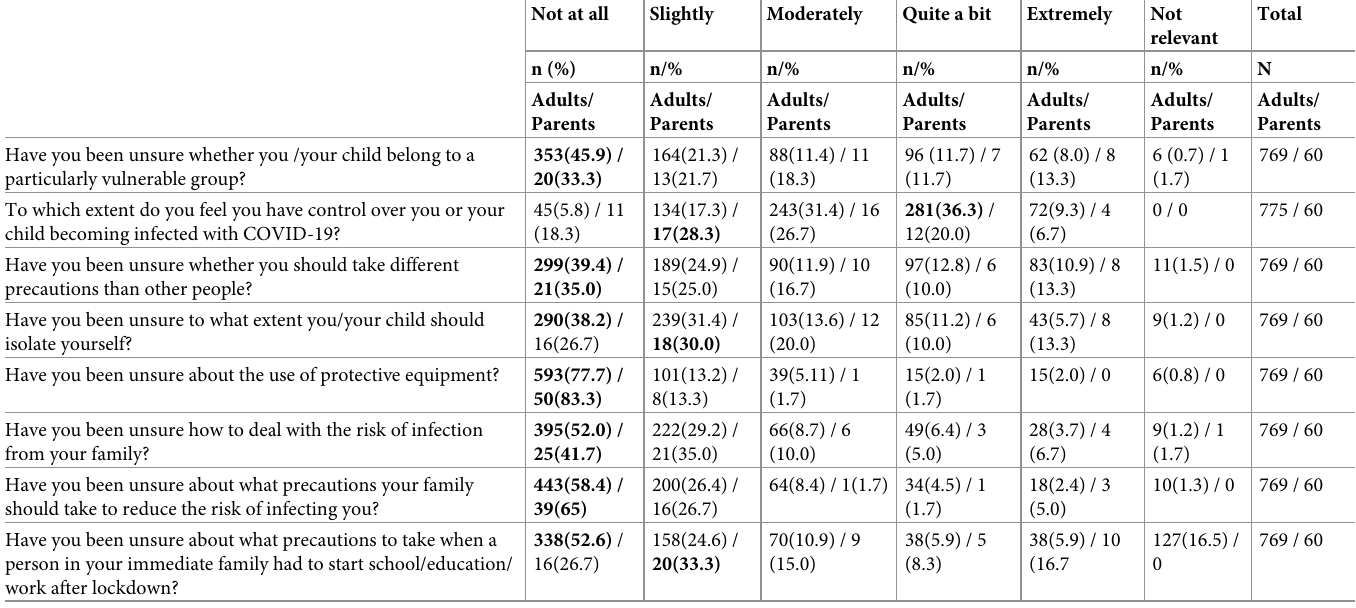
Table 4. Perceived uncertainty on how to protect oneself or one’s child from infection with